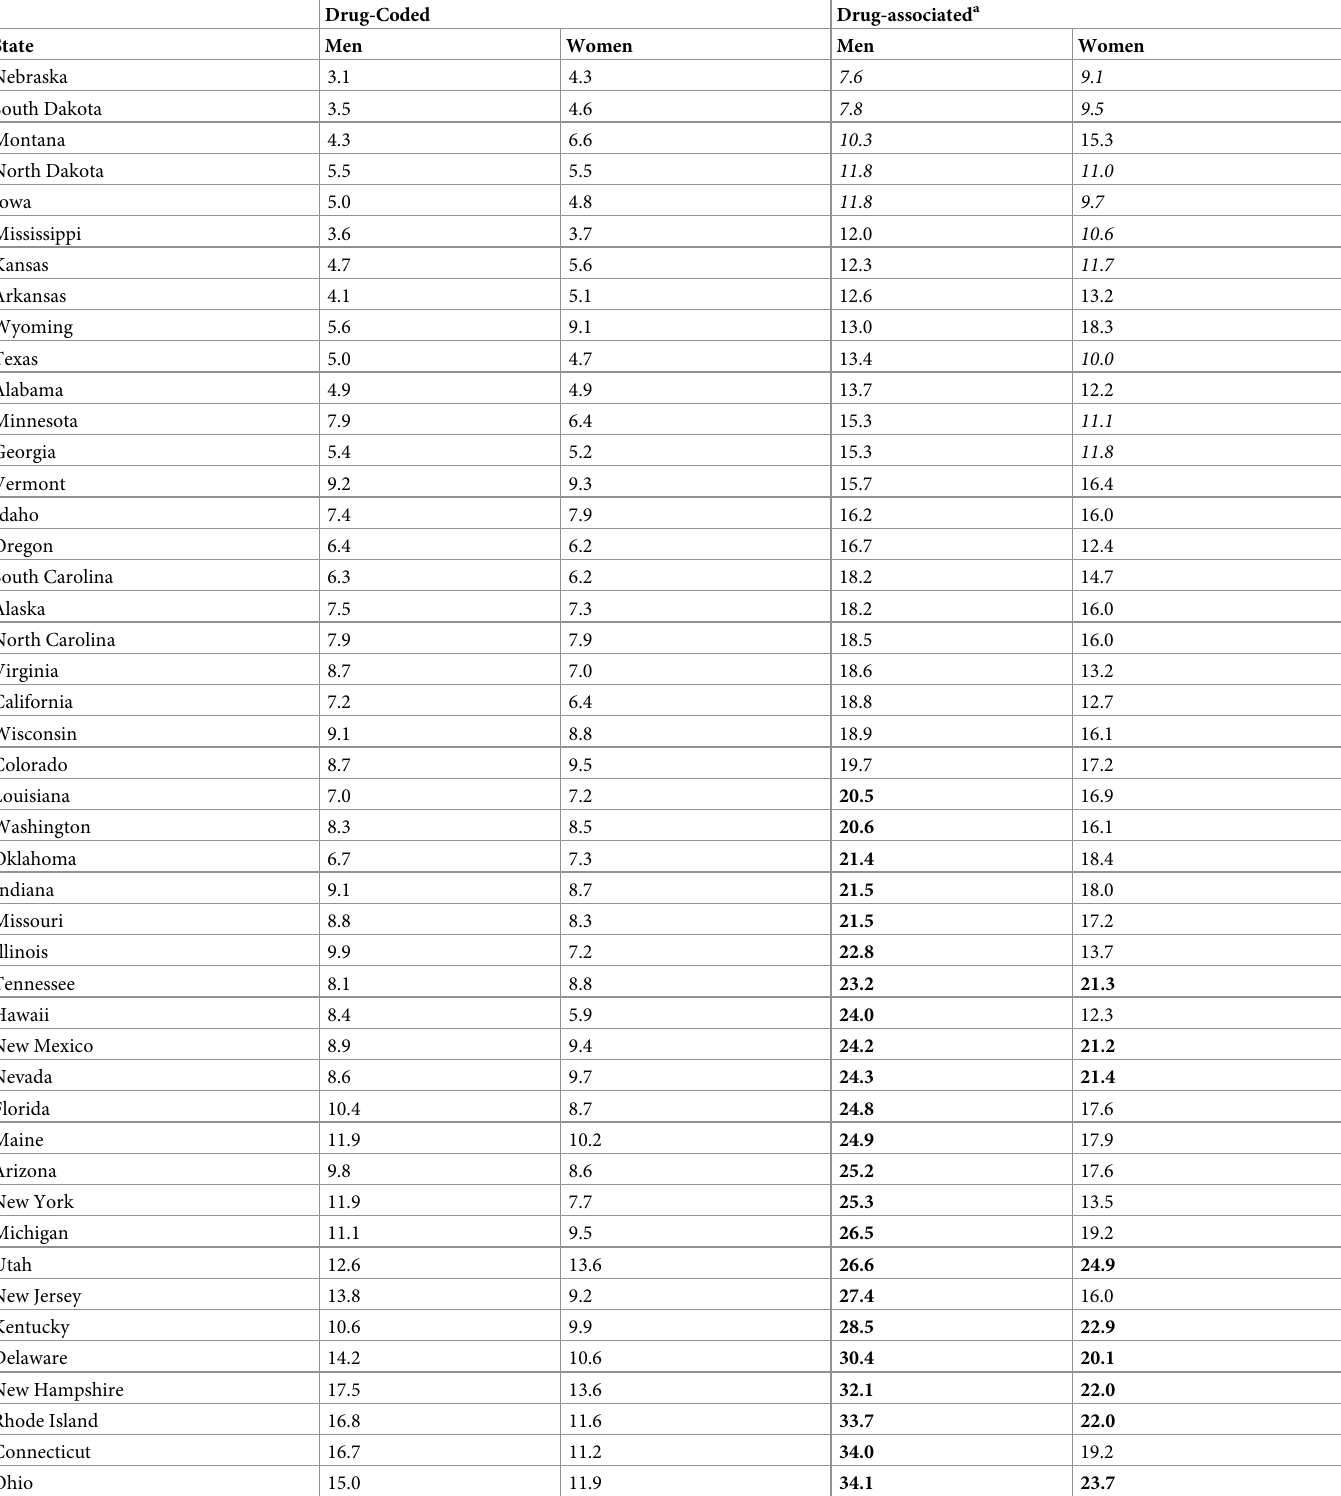
Table 2. Percentage of deaths at ages 15–64 that are drug-coded and drug-associated, by sex and state, 2016. Drug-Coded Drug-associated a State Men Women Men